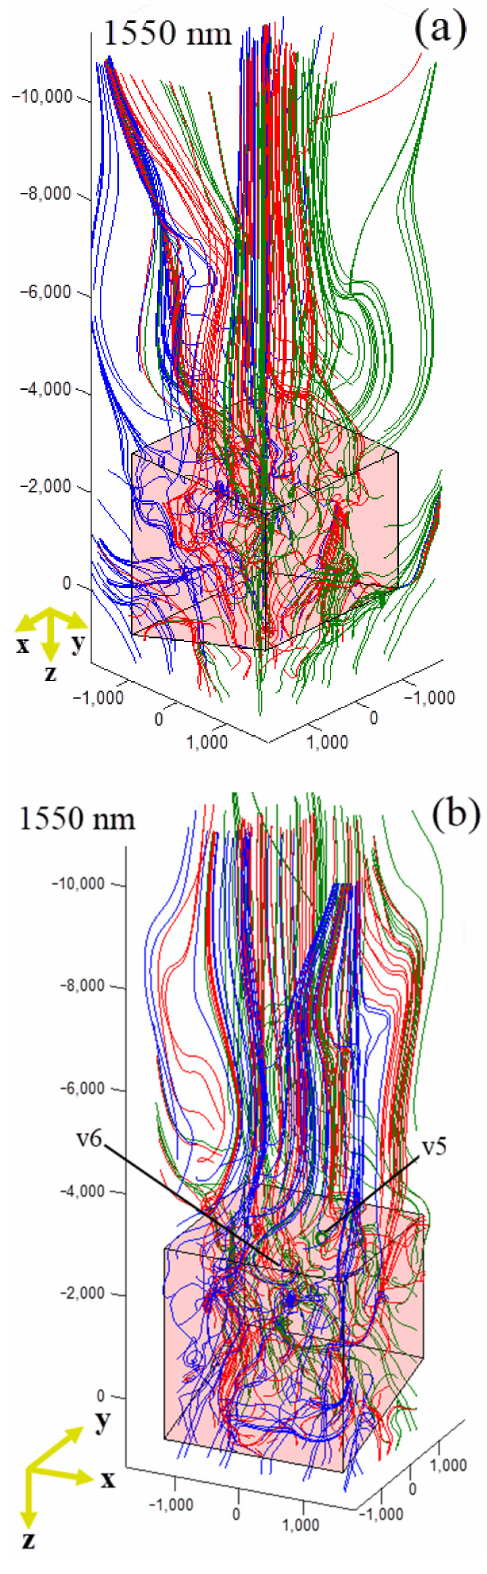
Figure 5. Overview ( a ) and the rotated view ( b ) of 3D Poynting vector distribution for the model of 1550 nm irradiation with the colour codes of streamlines: blue lines for long-base section ( − y direction), red lines for middle section (around 0 position on y axis), and green lines for short-base section (+ y